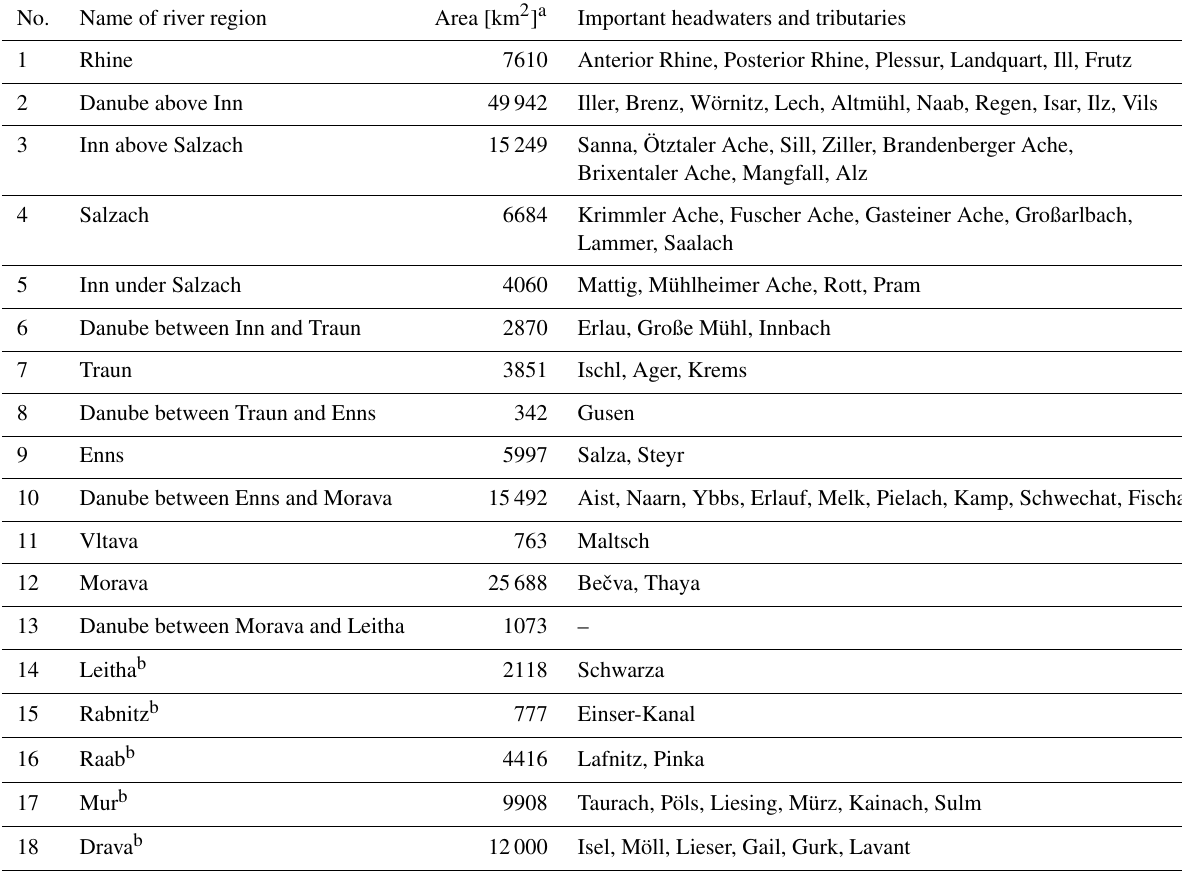
Table B1. Overview of the river